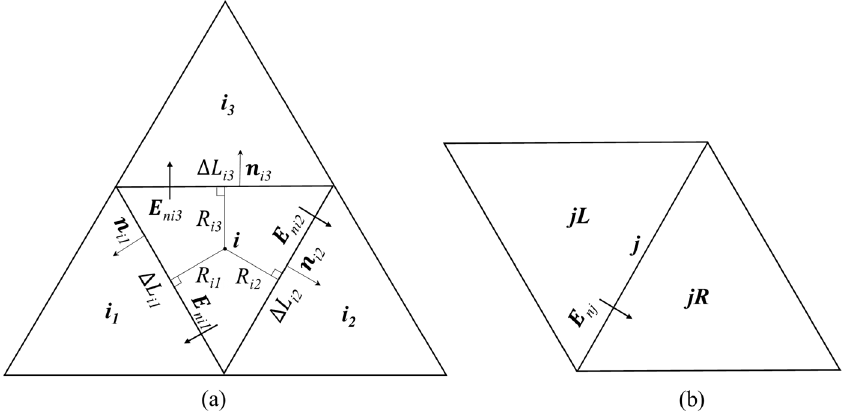
Figure 1. Sketches of the unstructured triangular meshes: ( a ) an internal cell ( i ) and its three neighboring cells; ( b ) a face ( j ) and its two neighboring cells ( jL and jR ).